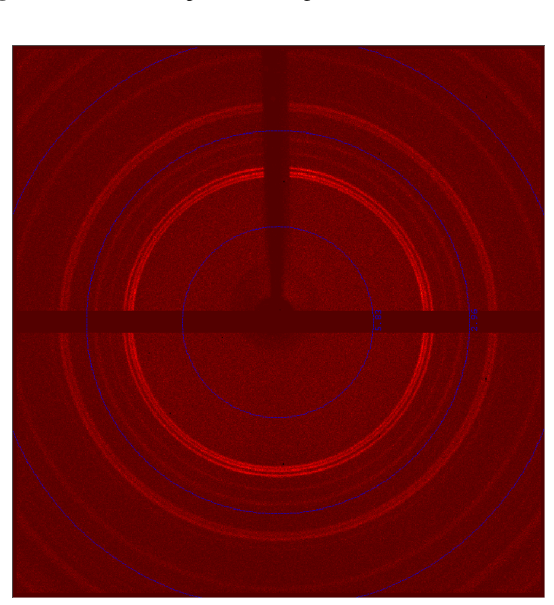
Figure 5. X-ray diffraction image of a triclinic grain of liguowuite (Mo K α